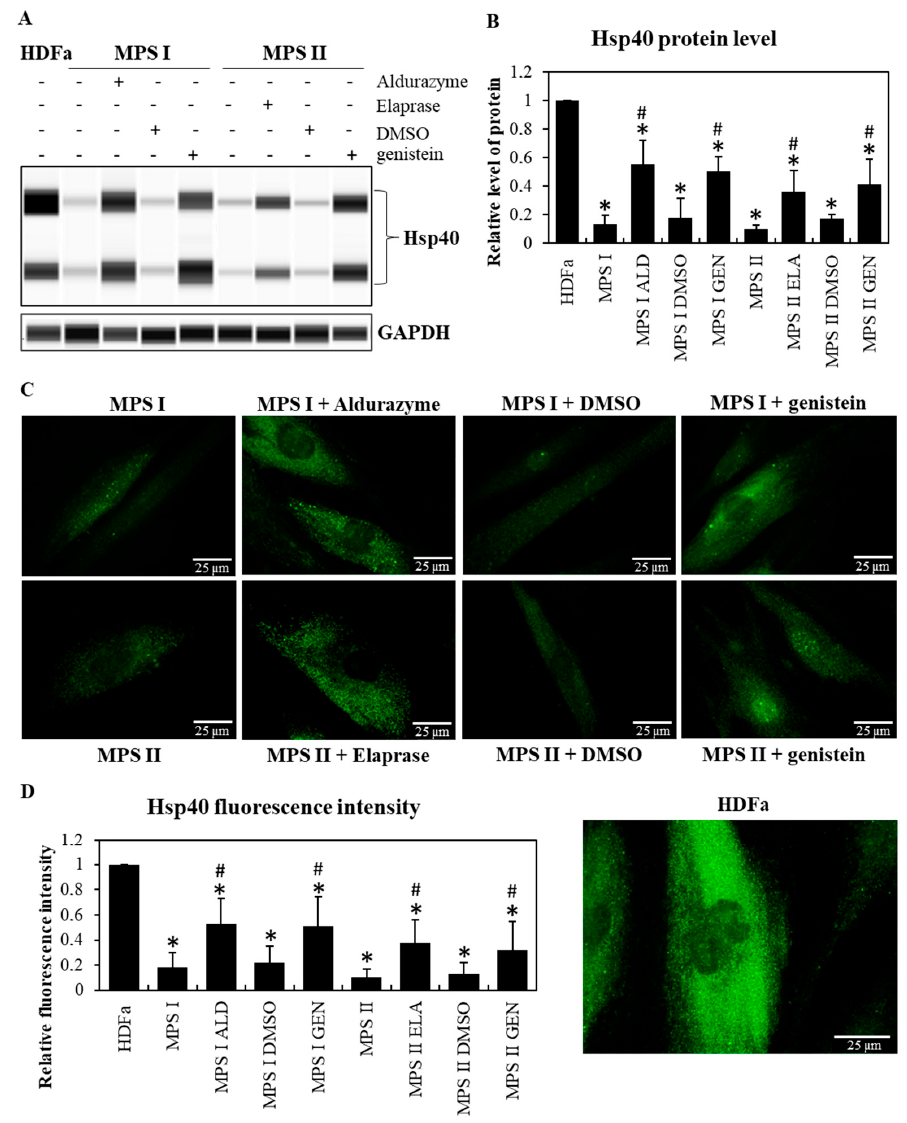
Figure 2. Decreased levels of Hsp40 in MPS cells and effects of ERT and SRT. Western blotting ( A , B ) and immunofluorescence ( C , D ) analyses of the abundance of Hsp40 in MPS I and MPS II fibroblasts, relative to HDFa control cells, either non-treated (minuses) or treated (pluses) with Aldurazyme (ALD, recombinant α -L-iduronidase) at 0.58 mg/mL, Elaprase (ELA, recombinant 2- iduronate sulfatase) at 0.5 mg/mL, DMSO (solvent for genistein) at 0.05%, or genistein (GEN) at 50 µ M for 24 h. Panel ( A ) shows a representative Western-blot (with GAPDH as loading control) while panel ( B ) demonstrates quantitative analyses (based on densitometry) from 3 independent experiments with error bars representing SD. Panel ( C ) shows representative fluorescent microscopic pictures (with scale bars indicating 25 µ m), while panel ( D ) demonstrates quantitative analyses (relative fluorescence intensity) from 100 randomly chosen cells of each variant of the experiment. In panels ( B ) and ( D ), asterisks indicate statistically significant differences (at p < 0.05) relative to HDFa cells, and hashtags indicate statistically significant differences (at p < 0.05 in two-way ANOVA and post hoc Tukey’s test) relative to non-treated MPS I or MPS II